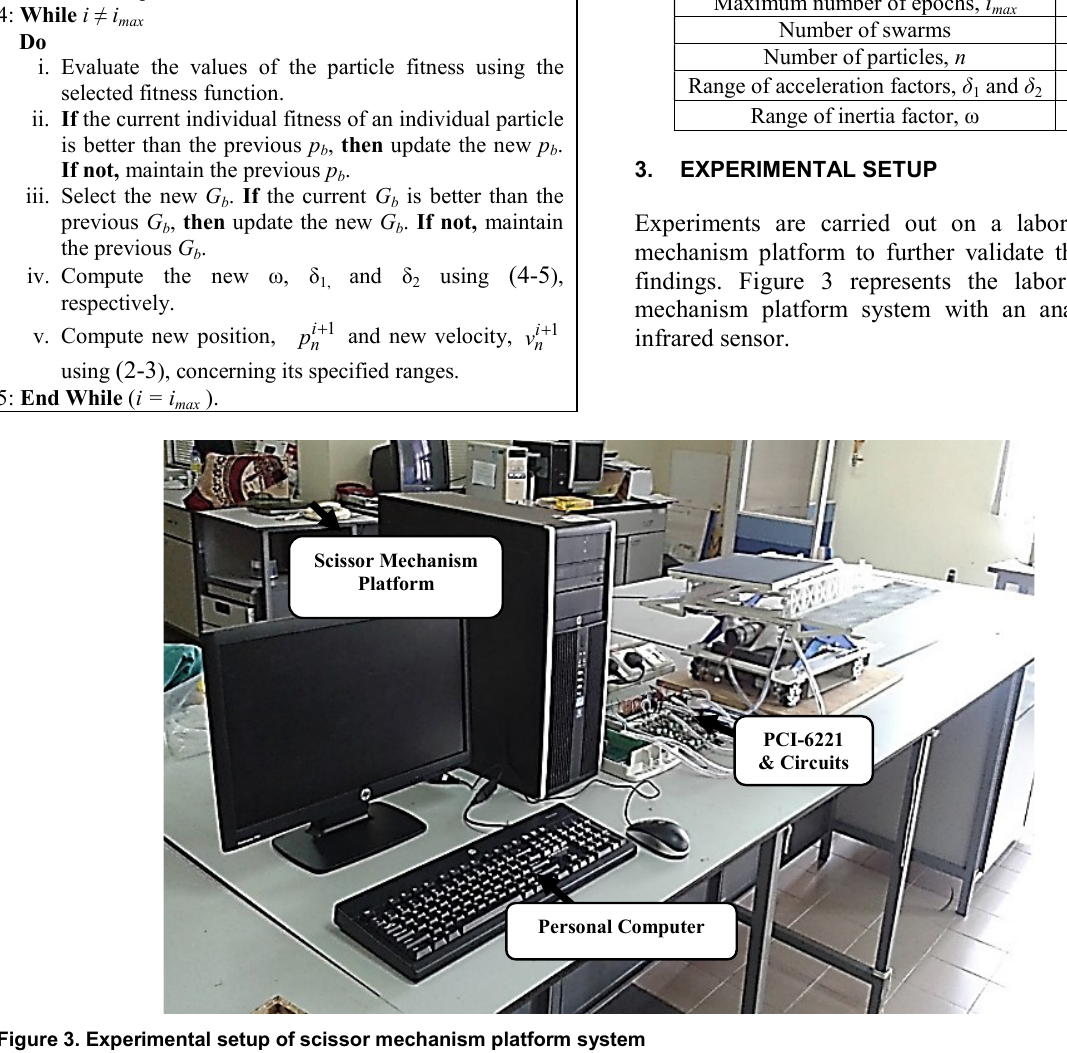
Table 2. PSO-SF parameters for gain tuning of the PSO- FOPID controller Parameters Values